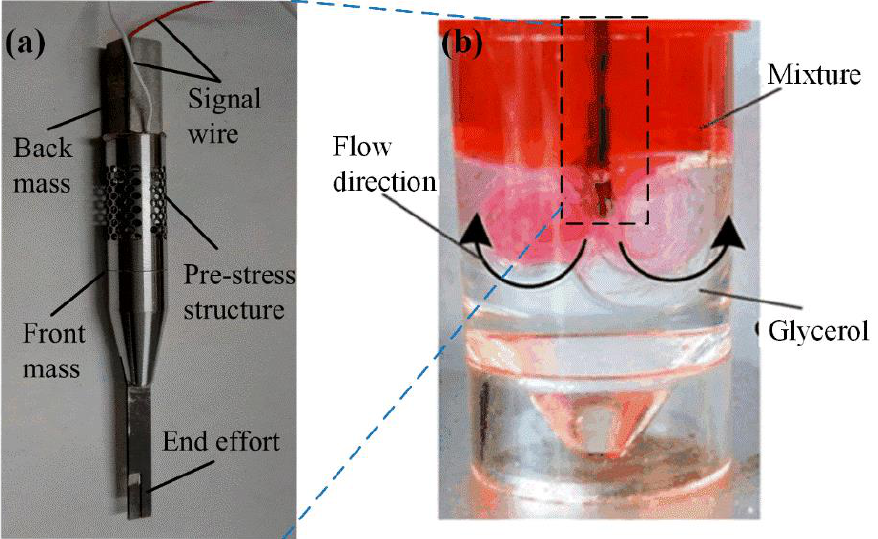
Figure 20. Stir performance test with ( a ) prototype of micro-stirrer and ( b ) visible flow